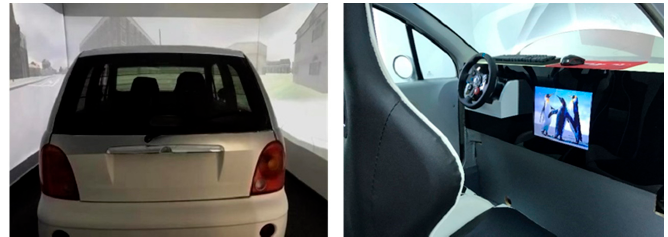
Figure 1. The driving simulator used in the current study.